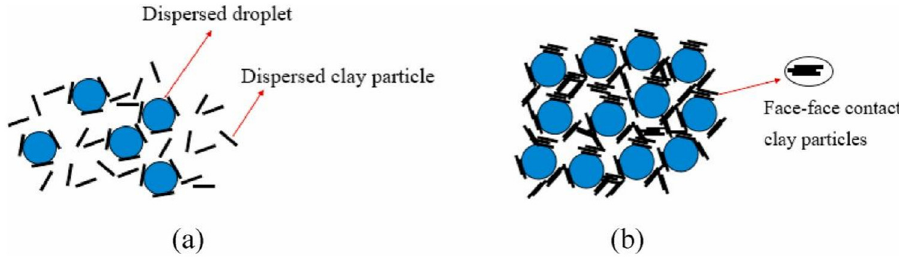
Figure 5: Pickering emulsion stabilized by clay at very low ( a ) and very high ( b ) salinities [ 48 ]